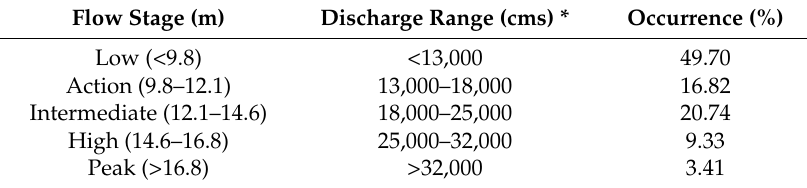
Figure 8. Seasonal trend of monthly mean, maximum, and minimum of daily discharge at Tarbert Landing of the LmMR during 1973–2013. Table 3. Long-term flow conditions based on the U.S. National Oceanic and Atmospheric Administration (NOAA’s) Mississippi River flow stages at Tarbert Landing of the LmMR from 1973 to 2013.